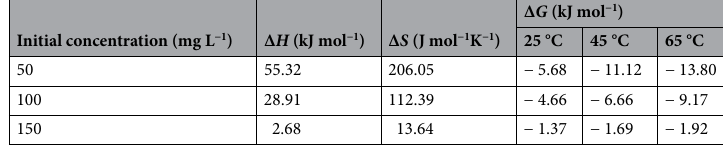
Table 4. Fitting parameters for the adsorption thermodynamics model of MRM.